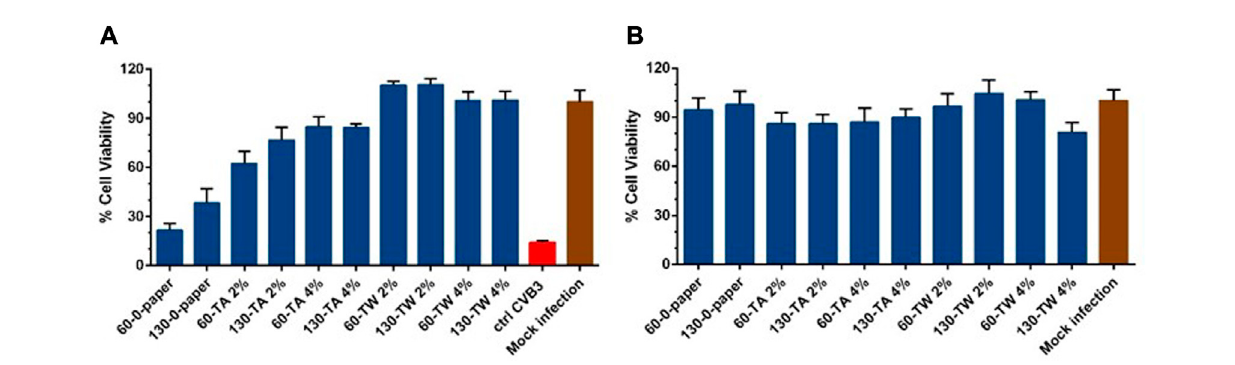
Testing the antiviral activity of paper samples against enterovirus coxsackievirus CVB3 (A) and cytotoxicity of paper samples on A549 cells (B) . Virus controlandtestsamplesarenormalizedagainstthemockinfection. Theresultsarethemeanoftwoindependentexperiments.Theresultsareexpressed as average values + standard errors of the mean